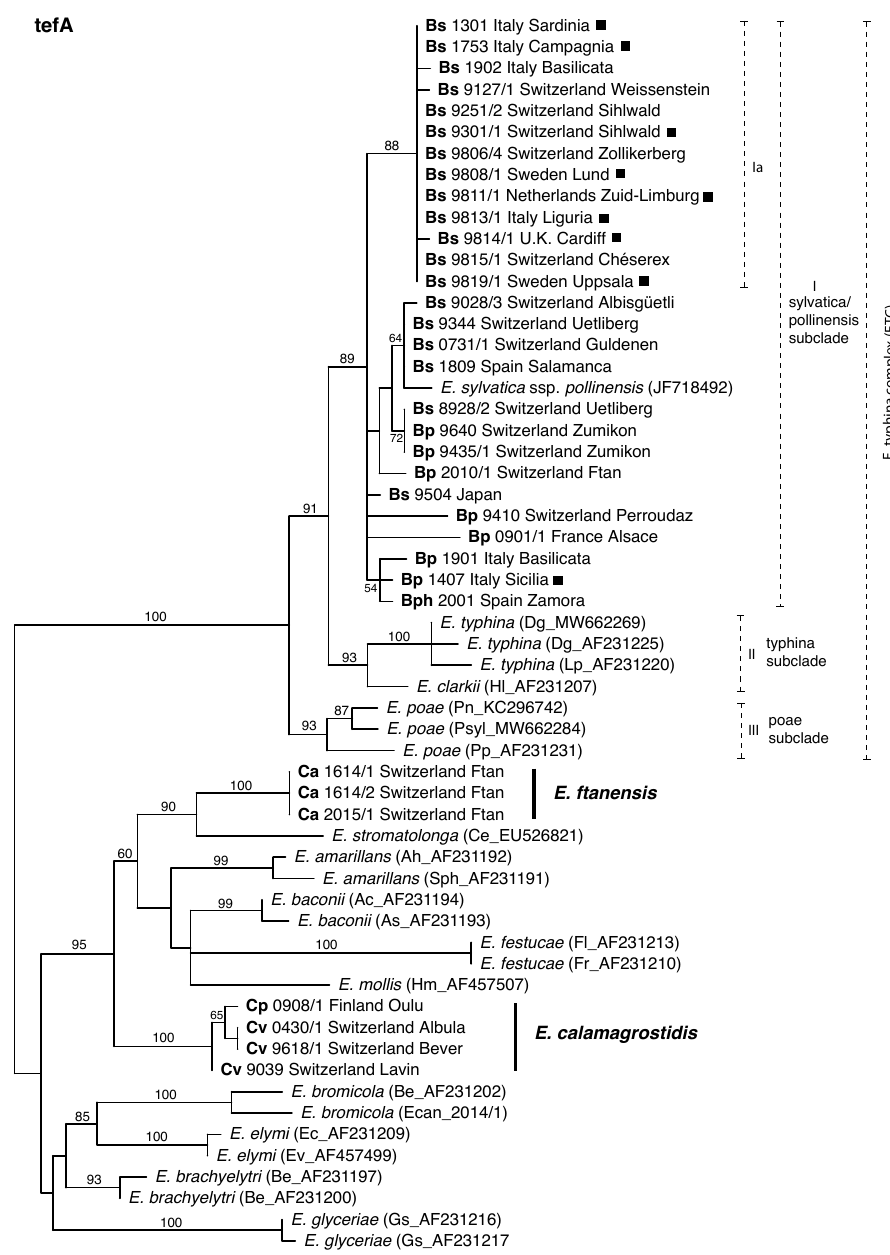
Figure 4. Phylogenetic tree inferred from maximum likelihood (ML) analysis of partial tefA gene sequences including introns 1–4 of Epichloë isolates obtained from Brachypodium and Calamagrostis host grasses: B. sylvaticum (Bs), B. pinnatum (Bp), B. phoenicoides (Bph), C. arundinacea (Ca), C. purpurea (Cp) and C. villosa (Cv). Asexual isolates are indicated with filled squares. Included are representative sequences of all other sexual Epichloë species or subspecies described to date. Dashed lines with Roman numerals denote distinct subclades. The tree is midpoint rooted at the left edge. Branch support values were estimated by 100 ML bootstrap replicates and are indicated if above